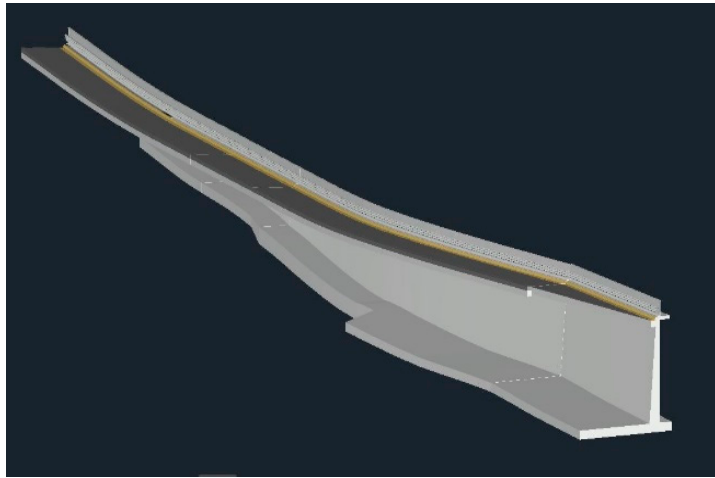
Figure 13. 3D view of retaining wall modeled using Subassembly Composer and imported in Civil 3D.